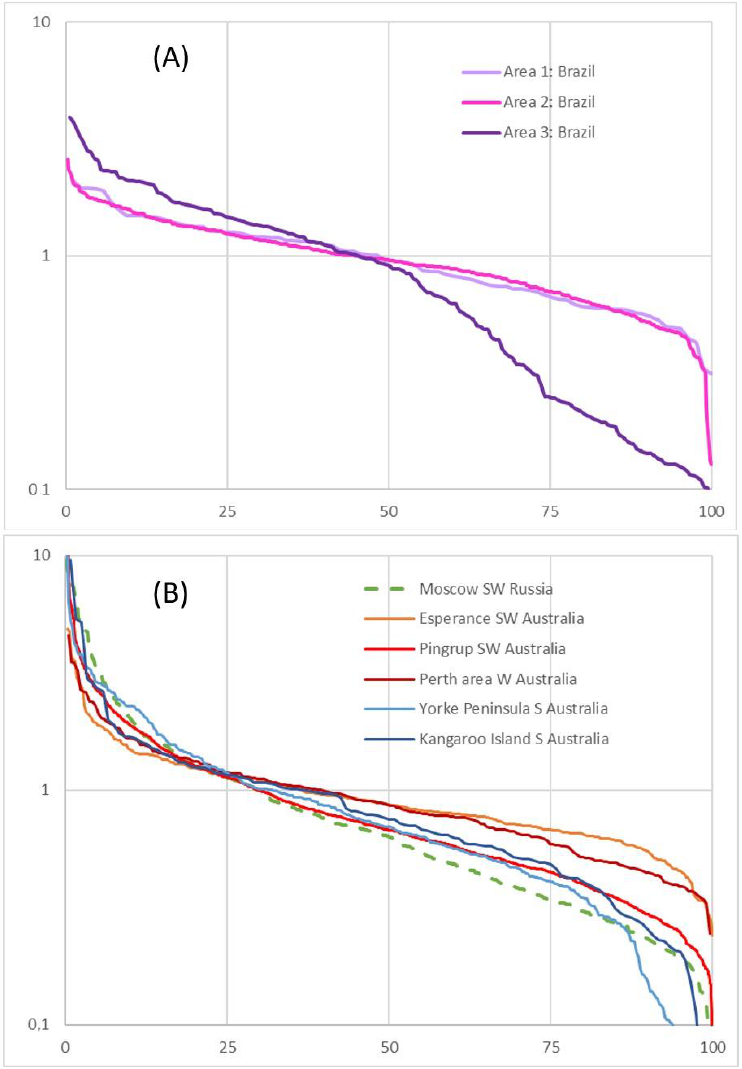
Figure 10. Distribution of the diameters in normalized values on the average. ( A ): data set from Brazil. ( B ): data set from Russia and Australia. Logarithmic scale on the vertical axis. This figure shows the dispersion of the values. A curve almost horizontal and where the value 1 is reached at 50% means that almost all the structures have the same dimension and that the average value and the most probable value are almost the same.